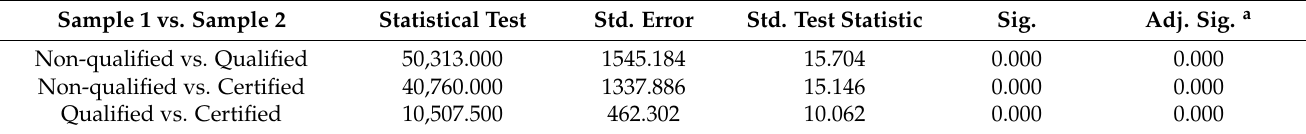
Table 6. Pairwise comparisons of the PMVA